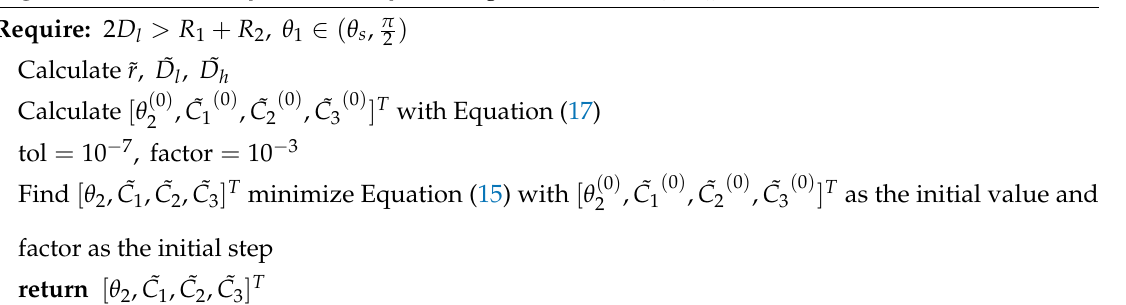
Algorithm 1 Calculate [ θ 2 , ˜ C 1 , ˜ C 2 , ˜ C 3 ] T when given R 1 , R 2 , D l , D h , θ 1 .